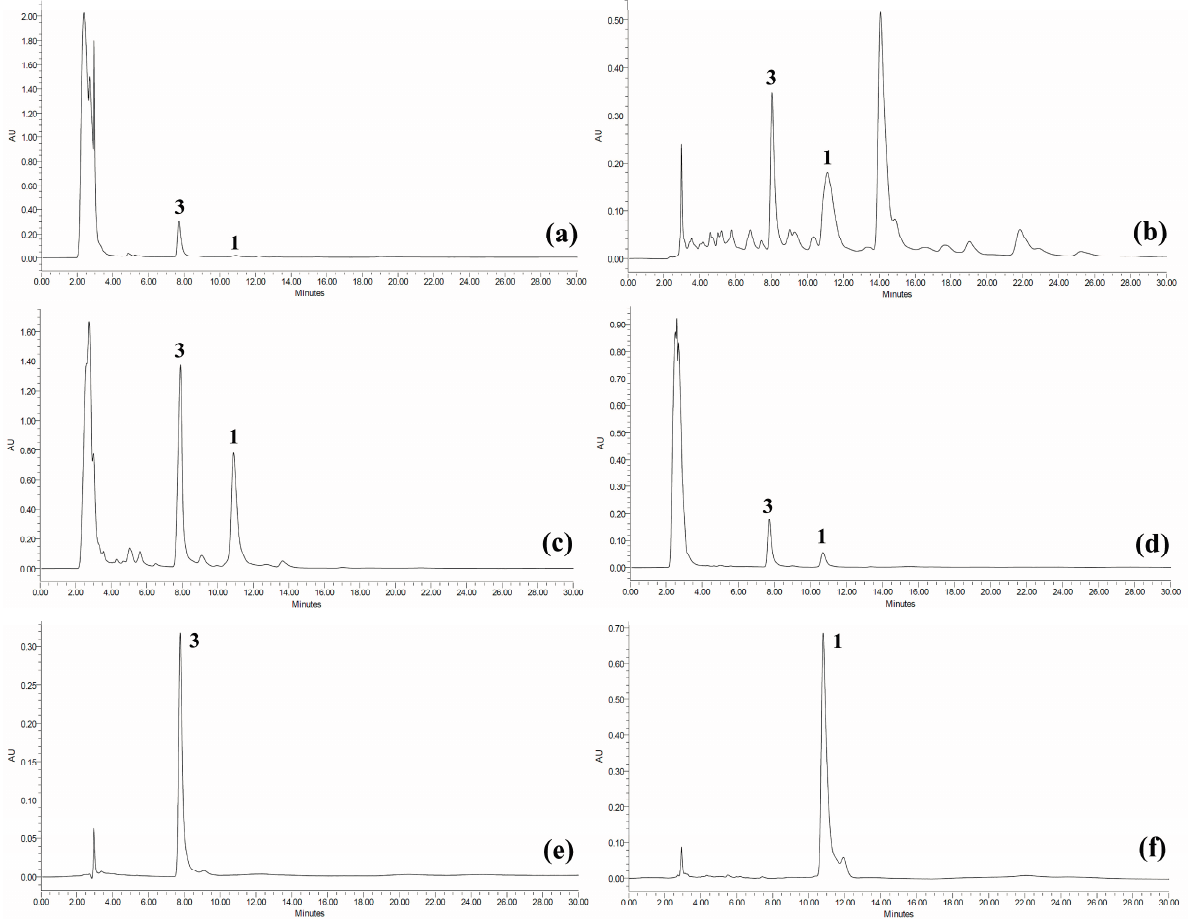
Figure 2. HPLC chromatograms for ( a ) crude MeOH extract, ( b ) petroleum ether fraction, ( c ) ethyl acetate fraction, ( d ) MeOH fraction, ( e ) isolated betulinic acid ( 3 ) and ( f ) isolated koetjapic acid ( 1